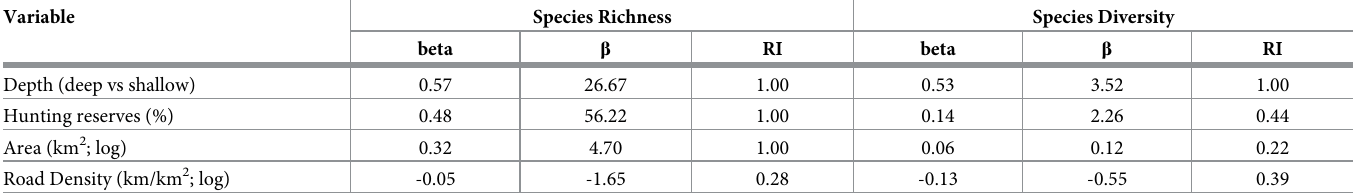
Road Density (km/km 2 ;